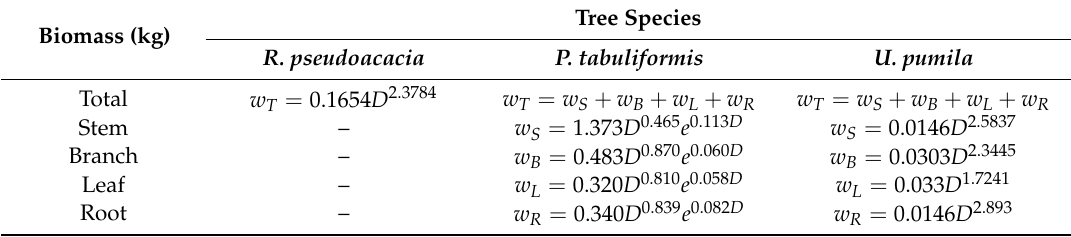
Table 1. Allometric equations for R. pseudoacacia , P. tabuliformis and U. pumila in Pingshuo opencast coal mine,